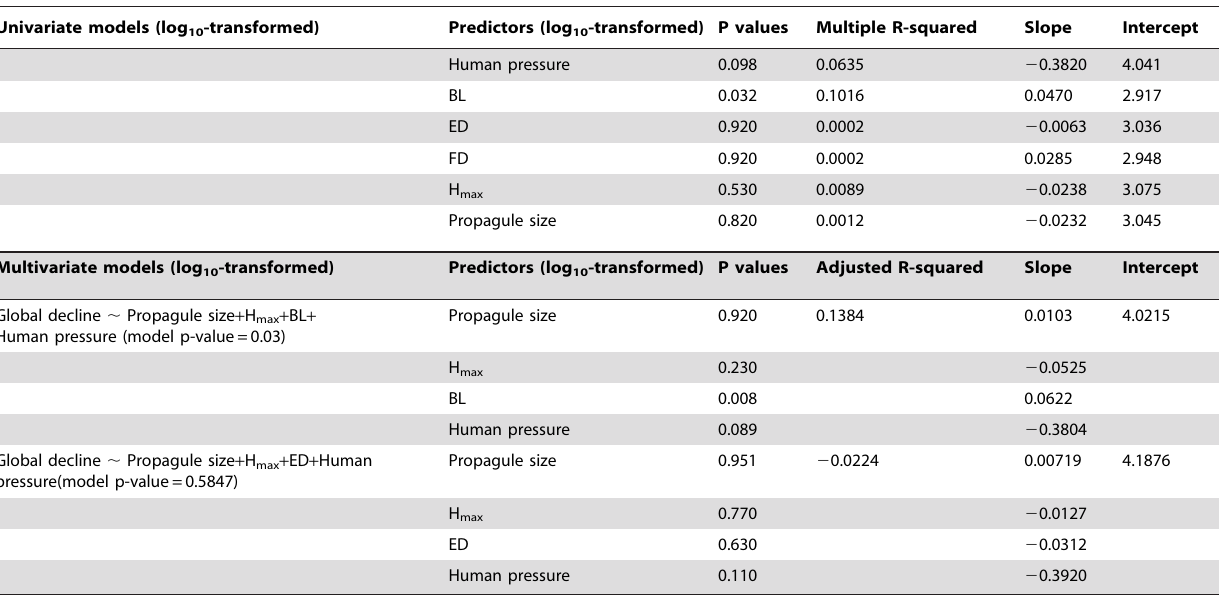
Univariate models (log 10 -transformed)